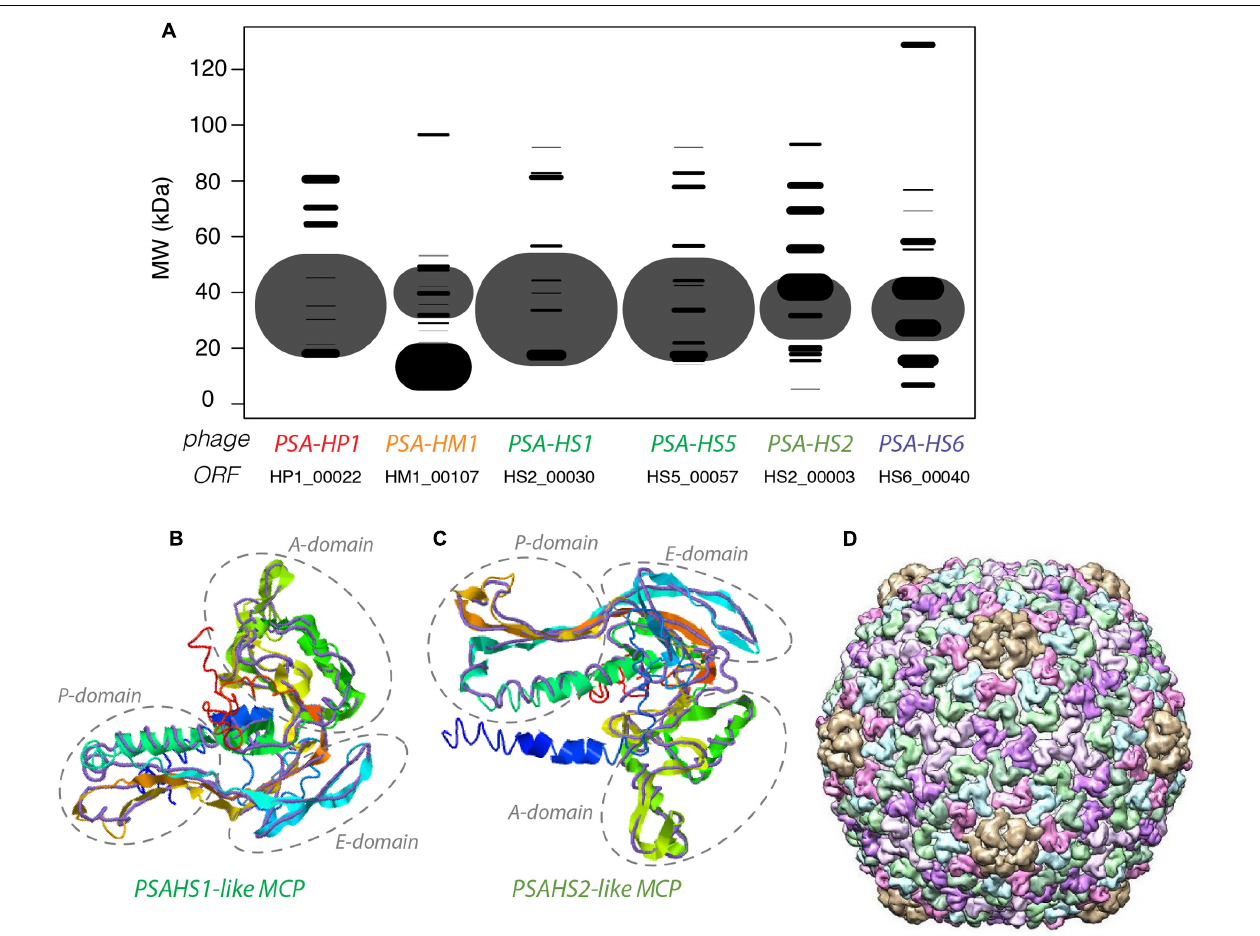
FIGURE 3 | (A) Modeled 2D SDS-PAGE gel representing structural proteins of a type phage from each of the new Helgoland Pseudoalteromonas phage genera. Band width is based on mass spectroscopy-quantified peptide abundances, as calculated by the normalized spectral abundance factor (NSAF; 2006)—essentially the predicted relative abundance of each protein in the virion of each phage. The size of the “fragment” represented the per phage NSAF. The largest bands in each row (phage major capsid proteins) are shown with transparency to allow visualization of overlapping bands (all other black bands). Band vertical position is based on molecular weights predicted from amino acid sequences. (B) 3-D prediction of PSA-HS1 phage major capsid protein (HS1_00030) with cryo-EM resolved backbone (purple) of Bacillus subtilis bacteriophage SPP1 protein, gp13. (C) 3-D prediction of PSA-HS8 phage major capsid protein (HS8_00019) with cryo-EM resolved backbone (purple) of Bacillus subtilis bacteriophage SPP1 protein, gp13. (D) Reconstructed capsid of Bacillus subtilis bacteriophage SPP1 protein, comprised of multiple gp13 subunits, which we predict to be analogous to the PSA-HS1- and PSA-HS2-like genera